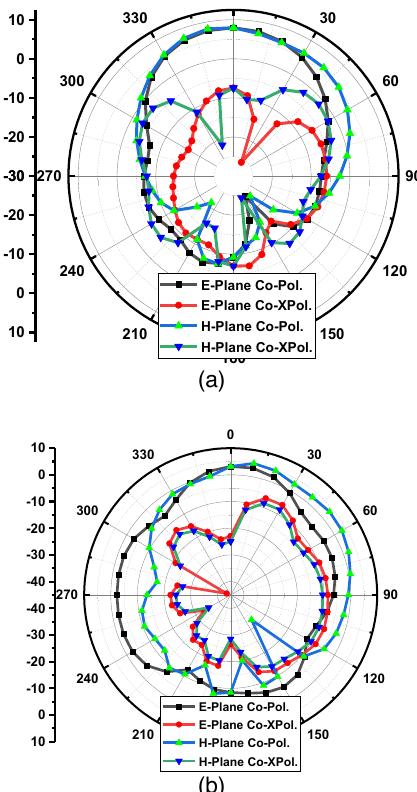
FIGURE 9. The proposed MIMO antenna radiation patterns at (a) 28 GHz and (b) 38 GHz.